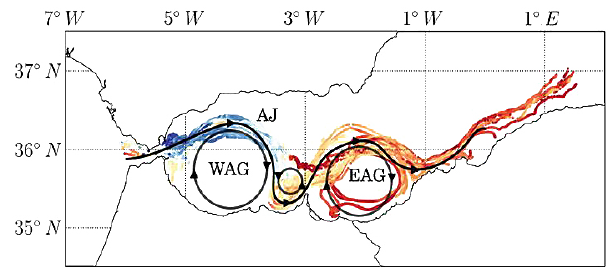
Figure 3. Sketch of the classical surface circulation of the Alboran Sea adapted from Sanchez-Garrido et al. (2013) with the MEDESS- GIB drifters superimposed. Contours represent stream lines. The Atlantic jet (AJ), the Western (WAG), and Eastern (EAG) Alboran gyres are labeled.